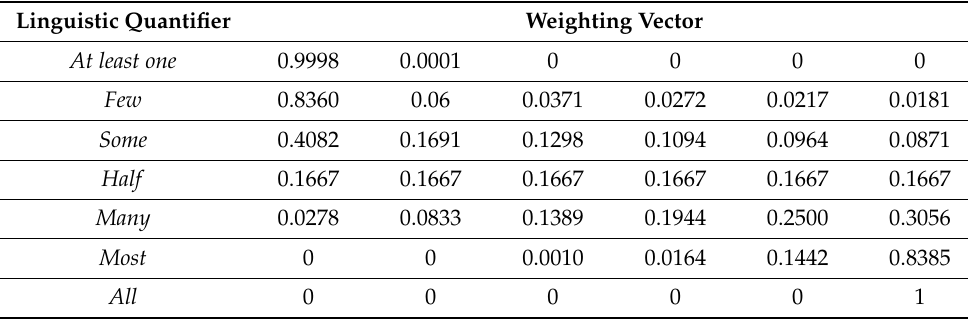
Table 3. Weighting vector for each linguistic